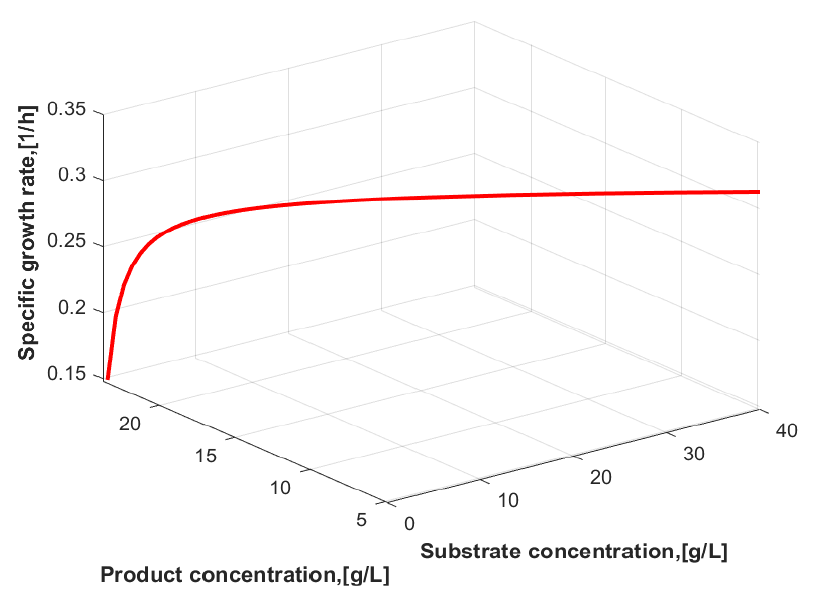
Figure 1. A 3D line plot of the specific growth rate as a function of substrate and product concentra- tions.